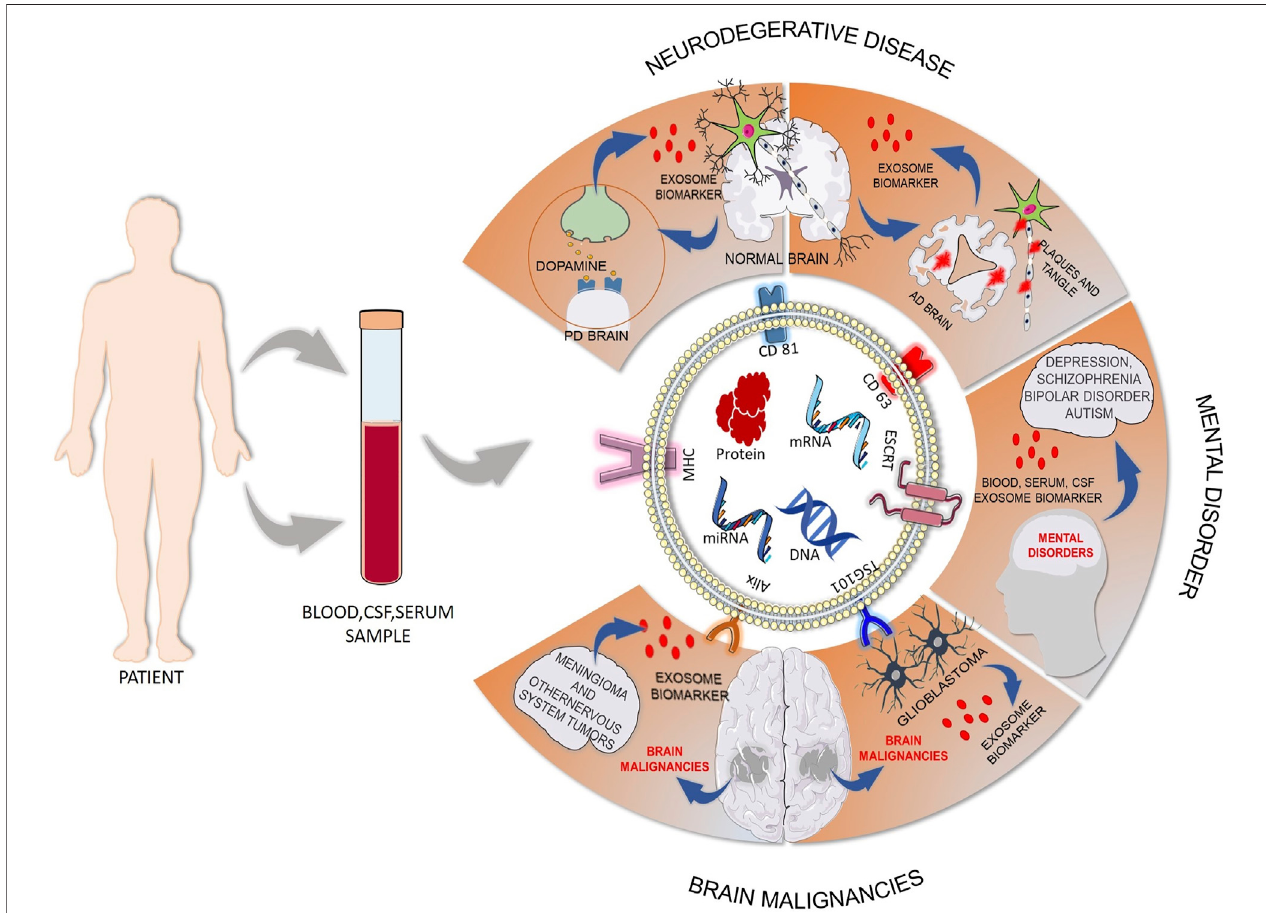
FIGURE 4 | Exosome-based biomarker discovery in neurological disorders from bio fl uids. Blood, cerebrospinal fl uid, plasma, or serum sample can be collected frompatients,andthecontentoftheisolatedexosomesfromthatsamplecangiveustheopportunityinearlydetectionofdiseasetogainknowledgeaboutdiseasestate and diseaseseverity.This fi guregivesasnapshotofexosomereleasefromdiseasestateslikeneurogenerative disease, mentaldisorder,andbrainmalignanciesandthe biomarkerpotentialofexosomes.(AD:Alzheimer ’ sdisease;PD:Parkinson ’ sdisease)[Somecomponentofthe fi